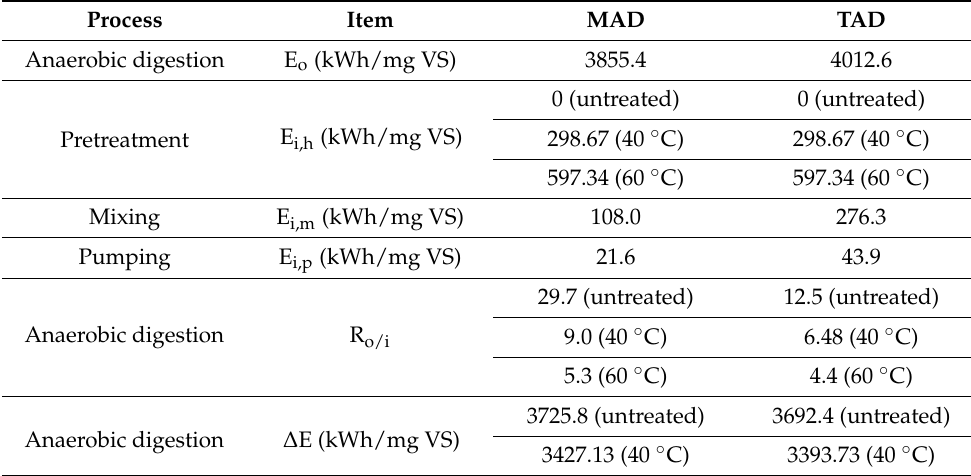
Table 6. Energy balance of MAD and TAD systems during the steady